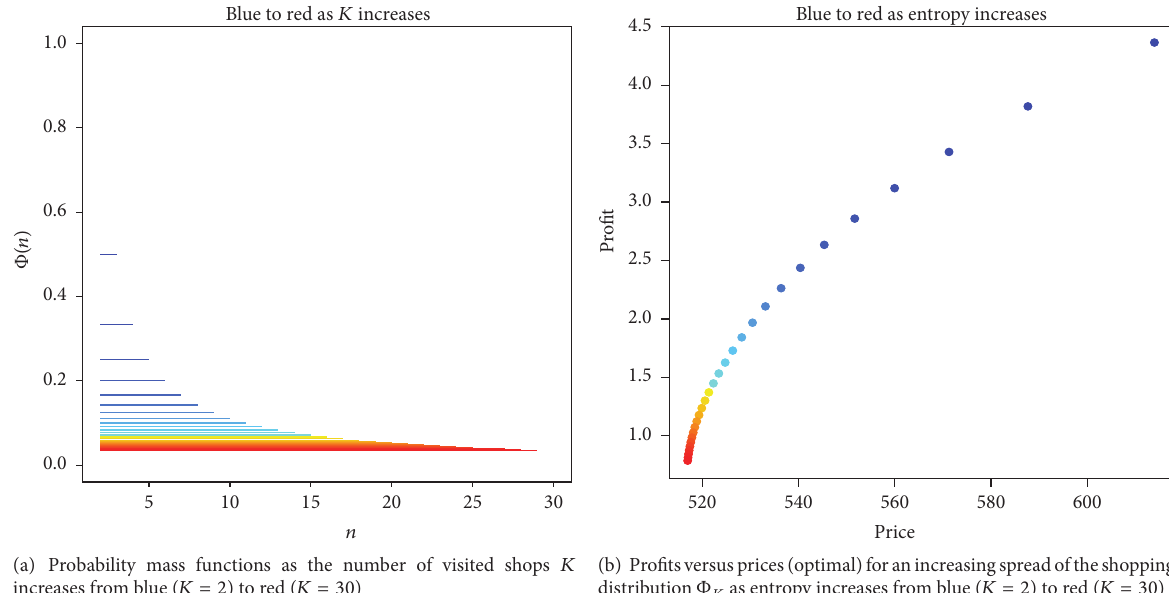
Figure 3: The seller’s solution under a uniform spread of shopping behavior. Main parameters in Table 3 and those used earlier as benchmark ( 𝜇 = 600, 𝜎 2 = 125, ] = 2, 𝛼 𝑐 = 0.15, 𝑁 = 30 ).